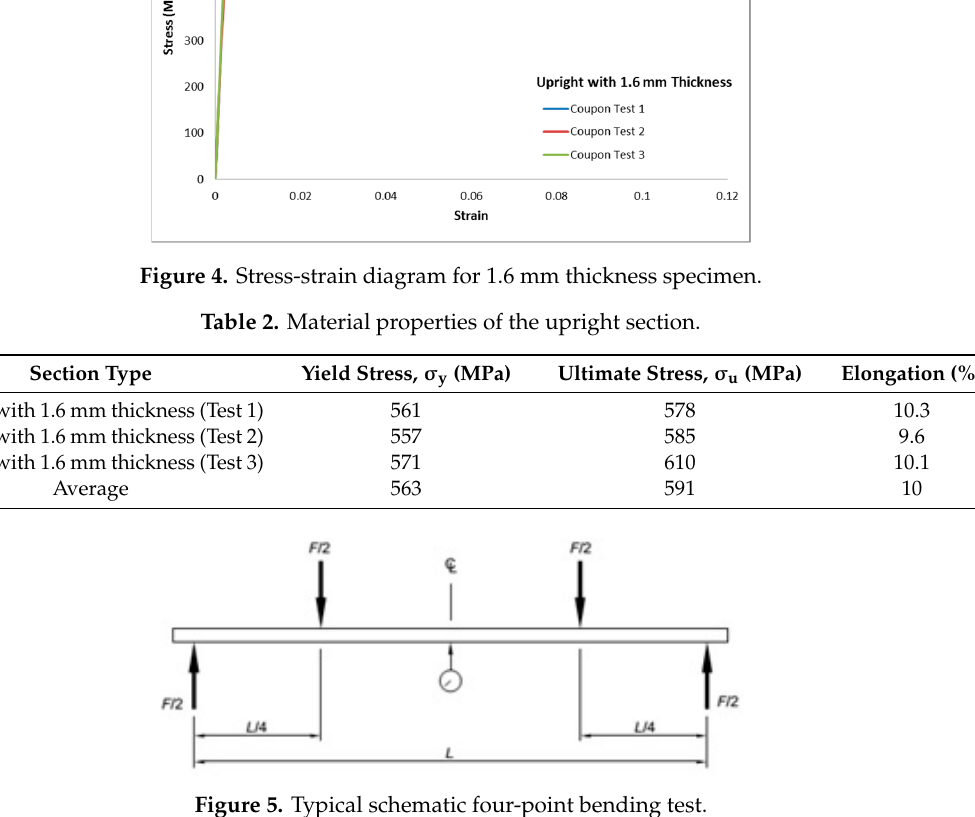
Figure 4. Stress-strain diagram for 1.6 mm thickness specimen. Table 2. Material properties of the upright section.